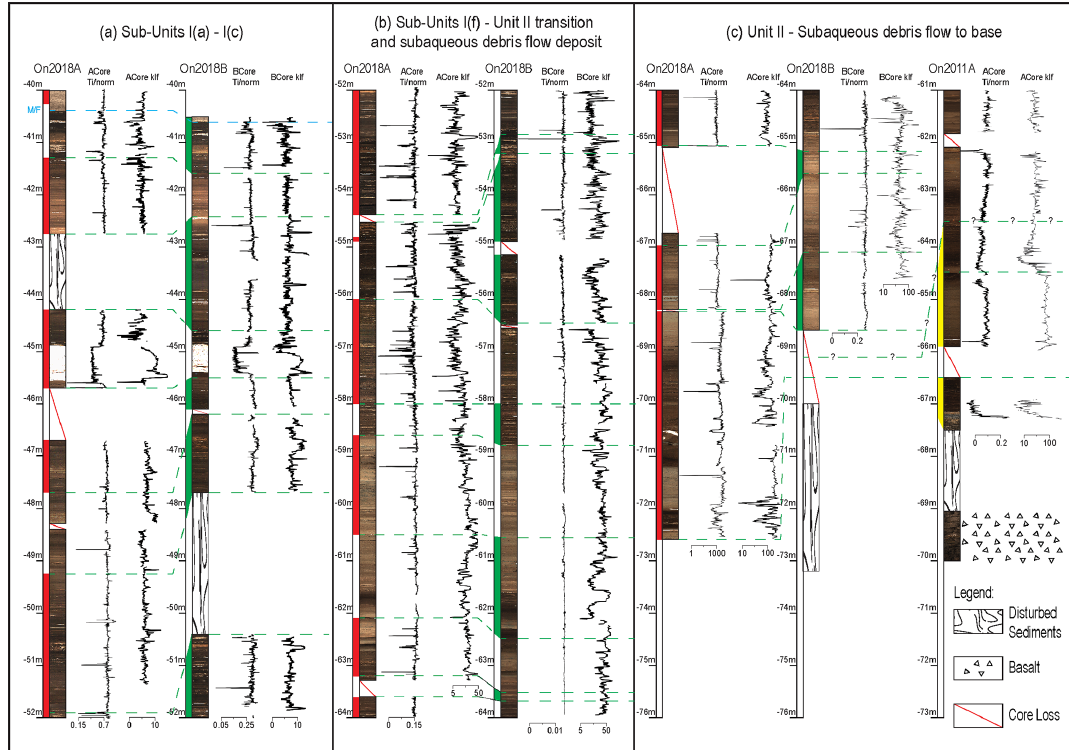
Figure 2. Schematic depiction of core section alignment using high-resolution optical images, Itrax µ-XRF Ti/norm., and low-field volumet- ric magnetic susceptibility (klf) data (dimensionless Si units × 10 − 5 ). Red highlights the 2018 core A (ACore) sample chosen for composite; green highlights the 2018 core B (BCore) sample chosen for composite; and yellow highlights the 2011 core A archive material chosen for composite. Symbol * represents normalisation with inc + coh to correct for variability in water and organic matter content, grain size, and ageing of the X-ray tube (Löwemark et al., 2011; Kylander et al.,